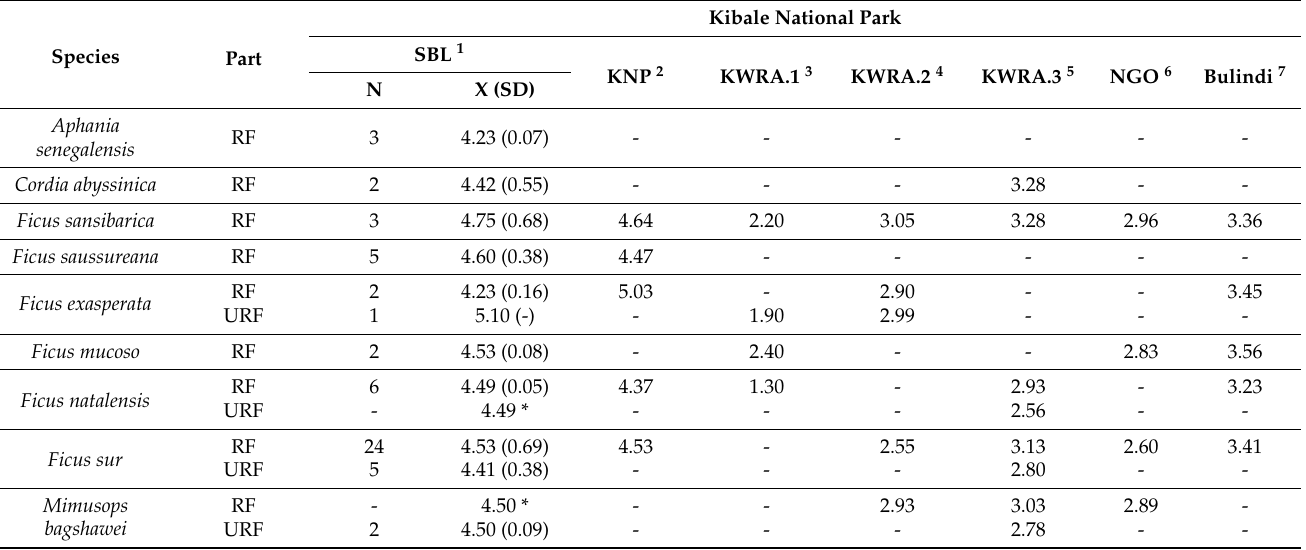
Table 2. Energy concentration (kcal/gDM) in 13 fruits from Sebitoli and intersite variations across